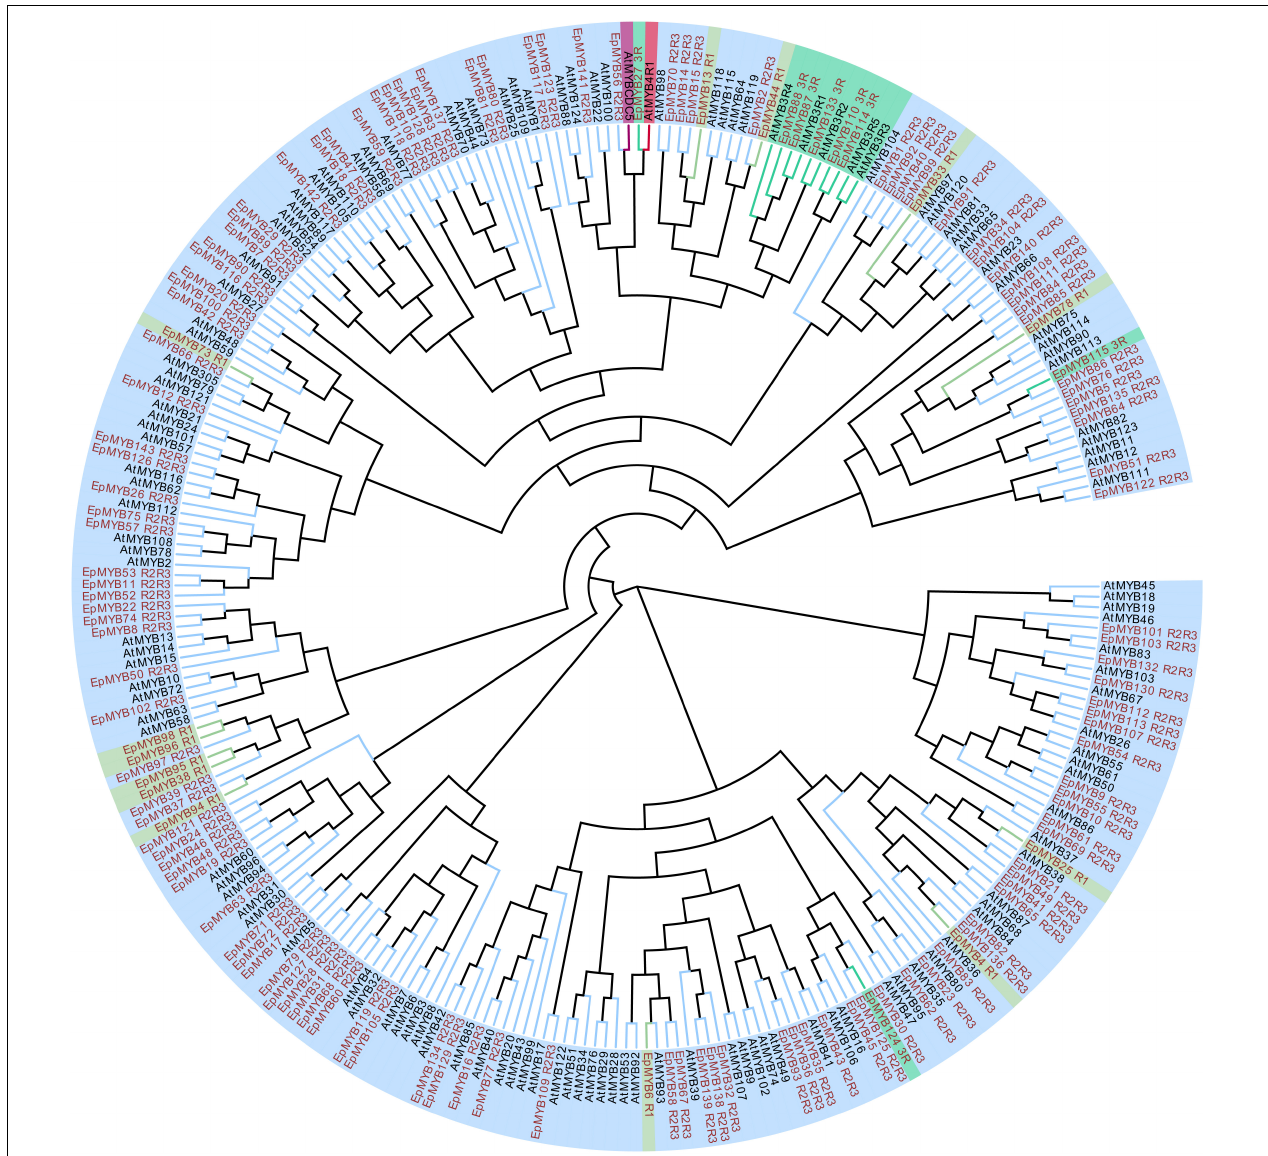
FIGURE 3 | Phylogenetic tree of EpMYBs . The EpMYBs are marked in red, AtMYBs are marked in black. The subgroups are marked in different colors on the periphery of the circle.